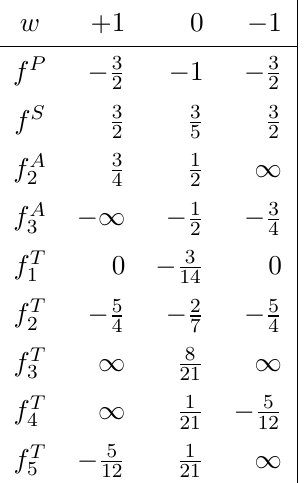
Table 1 . Asymmetry functions evaluated at w = 0 ; contribute to physical helicity amplitudes. In the singly-virtual limits the overall scaling also involves factors (1 = 2) (cid:0) n according to the de(cid:12)nition of Q 2 in (3.44).